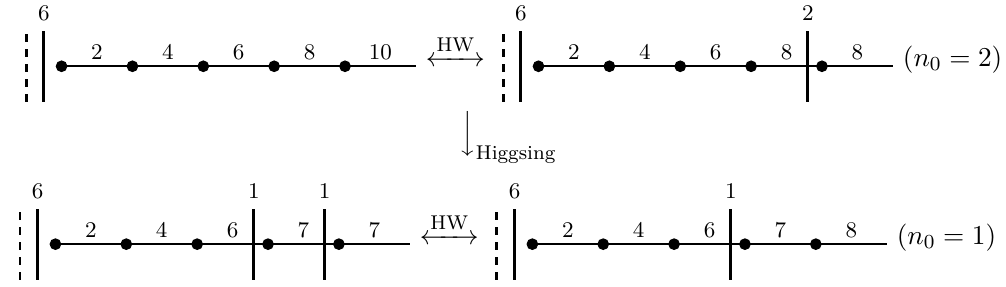
Figure 5. The top row represents a massive E-string theory at k = 10 , n 0 = 2 which, via Hanany- Witten (HW) moves, is equivalent to an orbi-instanton at k = 8 . Higgsing the flavor group on the stack of 2 D8’s results in the bottom row. Via HW moves, this is now equivalent to a massive E-string theory at k = 8 , n = 1 0